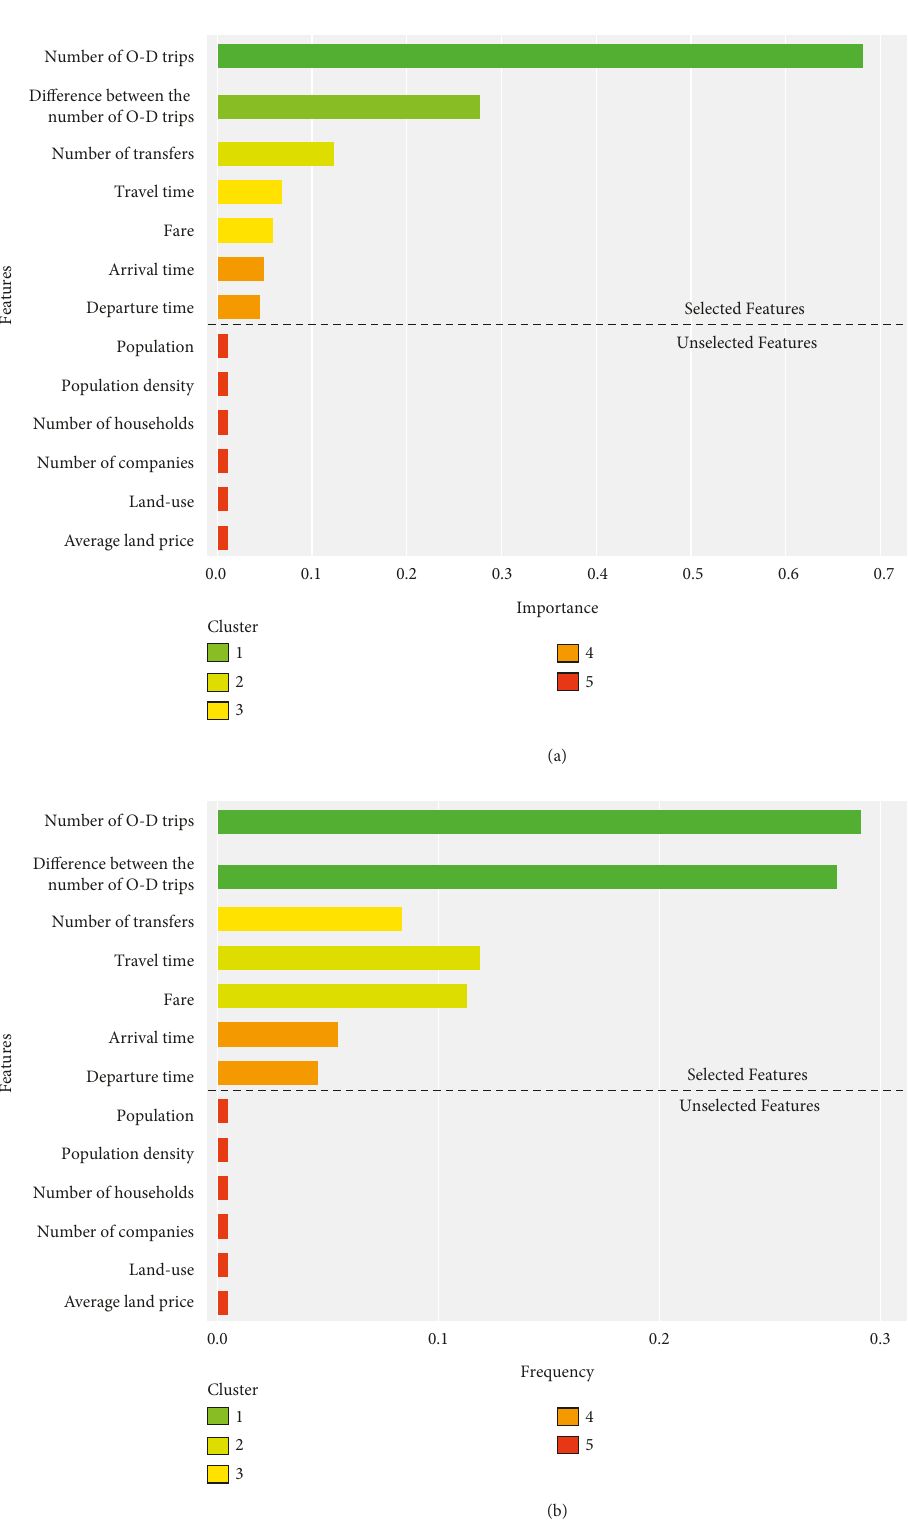
Figure 3: Results of feature selection analysis: (a) importance score; (b) frequency